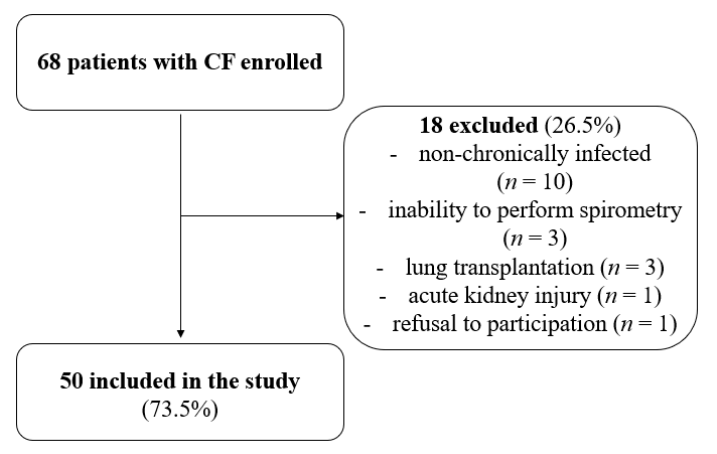
Figure 1. Flow chart of number of patients recruited and analyzed in the study. Healthy subjects were recruited at the same time. The control group consisted of sex-matched volunteers without any disease, including urinary tract disease or infection in medical history and physical examination. The volunteers had not been taking any medications 30 days prior to the study.